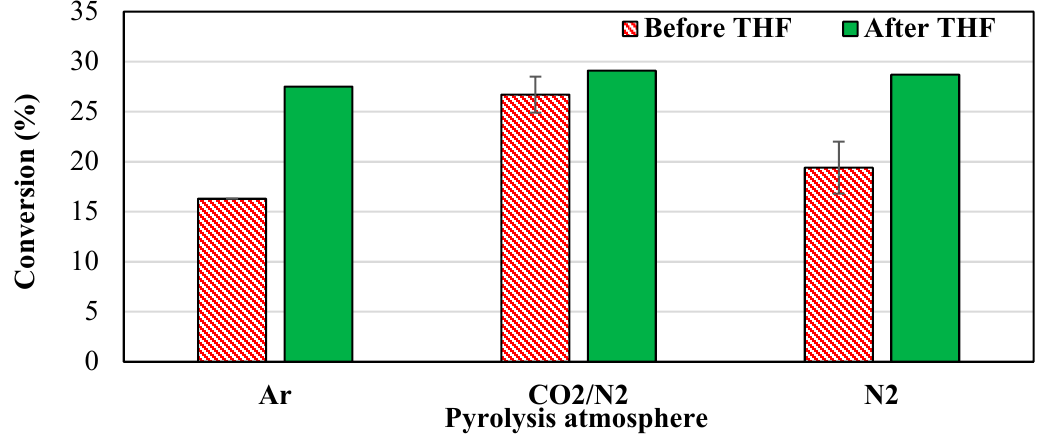
Figure 3. Volatile yield for chars generated in different pyrolysis Figure 3 . Volatile yield for chars generated in different pyrolysis atmospheres.